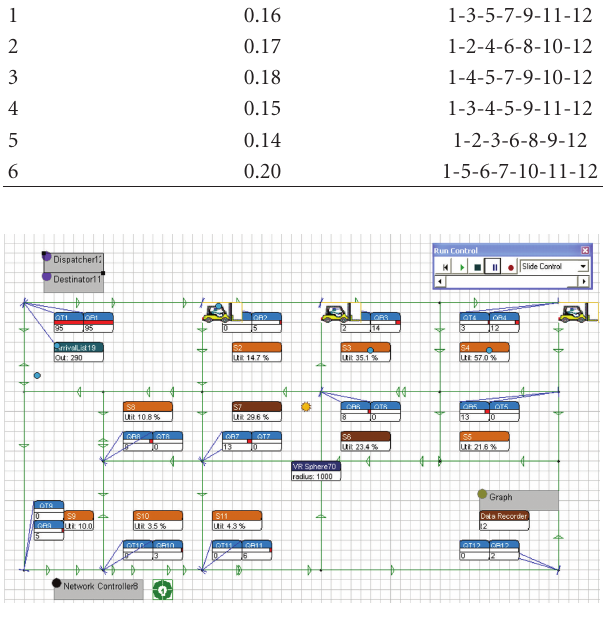
Figure 4: Two-dimensional